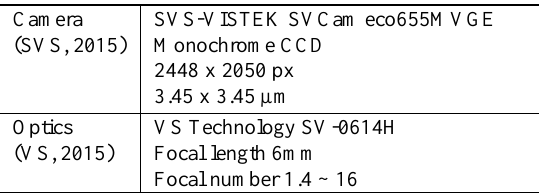
Table 1. Specifications of cameras and